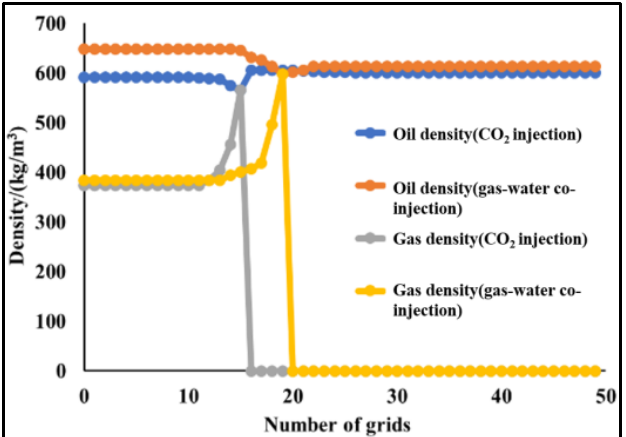
Figure 20. Variation of oil and gas density.